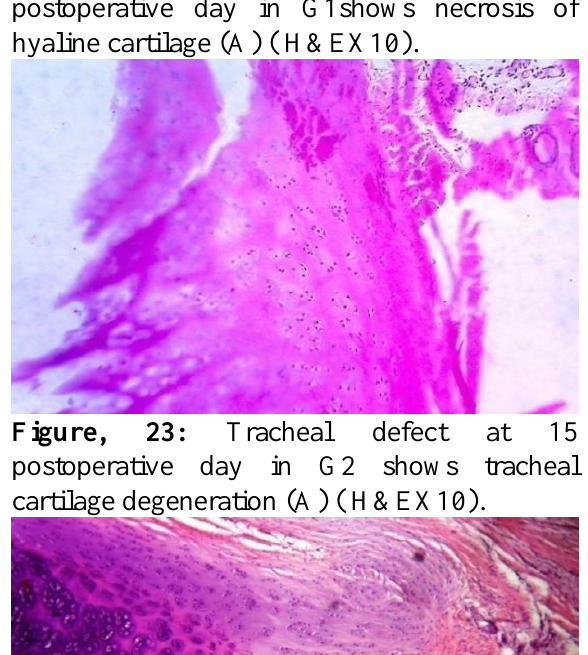
Figure, 22: Tracheal defect at 15 postoperative day in G1shows necrosis of hyaline cartilage (A) ( H&EX10).